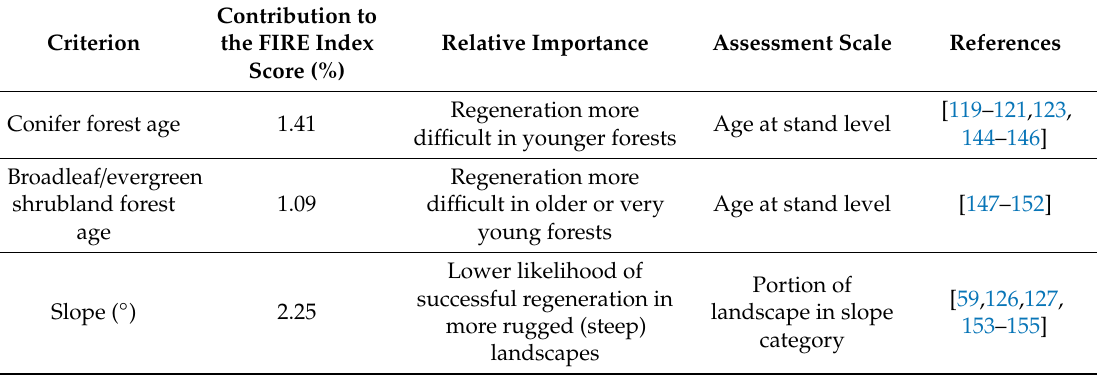
Table 3. Relative importance, assessment scale and relevant literature for each criterion for the regeneration potential and vegetation recovery fire e ff ects